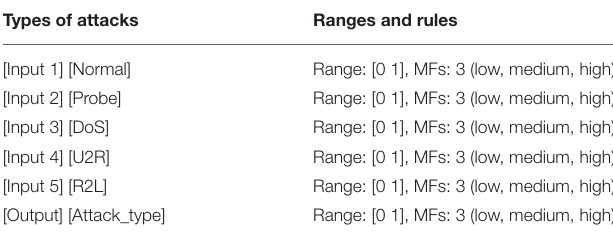
TABLE 3 | Input/Output parameters and membership